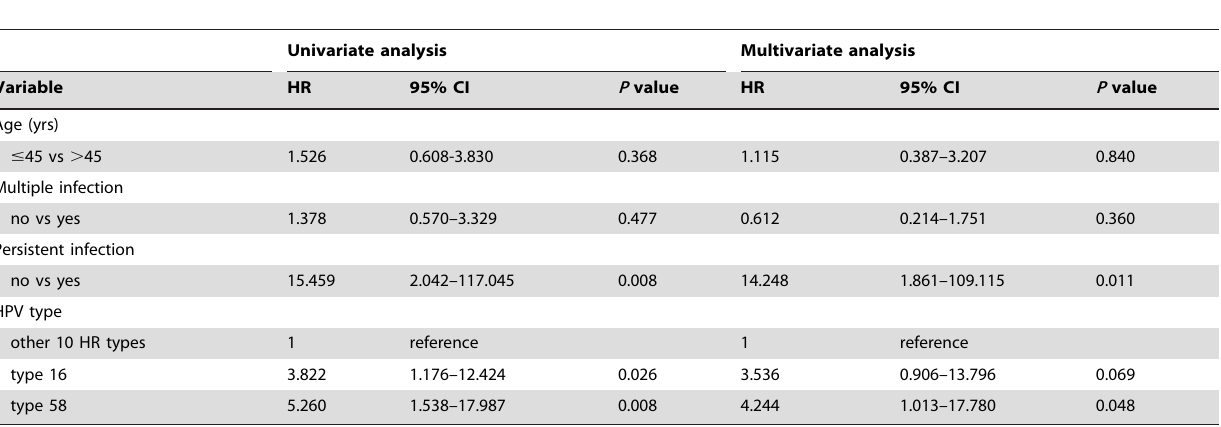
Table 2. Risk assessment of each factor for the development of HSIL in women who are high risk HPV-positive and cytology-